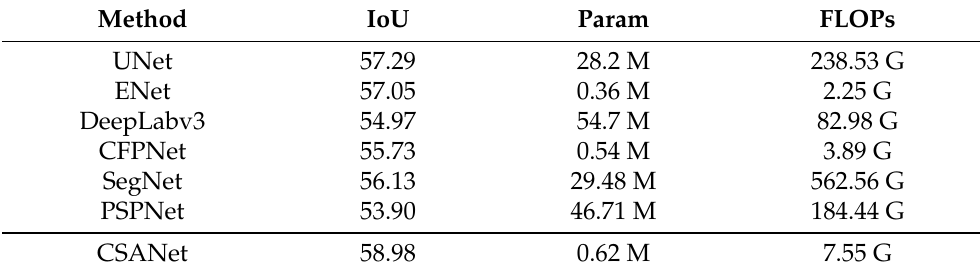
Table 5. Computation complexity and parameter sizes of different